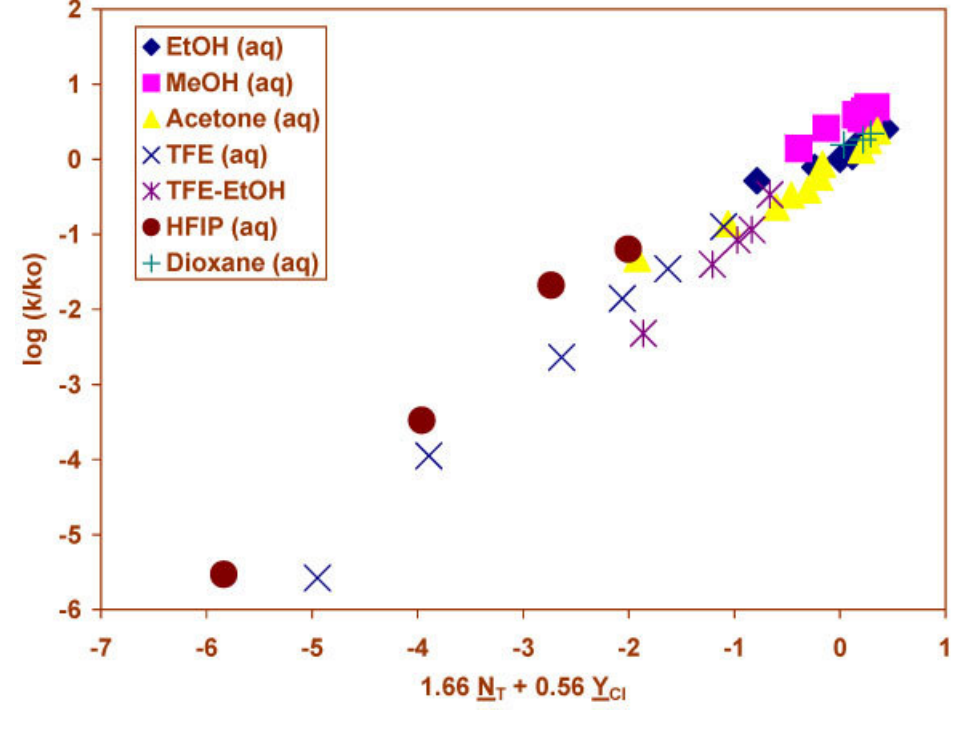
Figure 2 . The plot of log (k/k